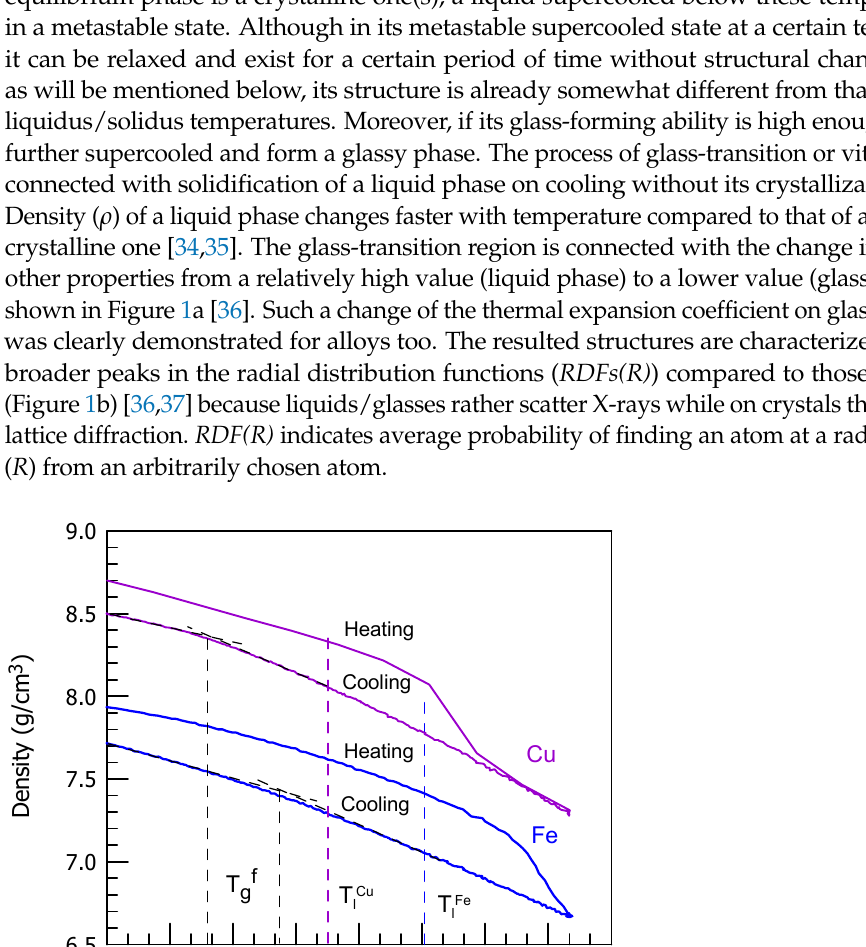
(b) Figure 1. Density changes on heating and cooling of Cu and Fe as a function temperature ( a ). Re- produced from [36] with permission of MDPI. RDFs of Fe in liquid at 1820 K (experiment and MD simulation) and glassy at 300 K (MD simulation only) state ( b ). The experimental RDF curve is taken from [37]. Vitrification of metallic liquids illustrated in Fig. 1a was modeled using molecular dynamics (MD) simulation. High critical cooling rates of about 10 13 K/s are required to vitrify pure metals in MD simulation [38,39] though theoretical calculations [40] and ex- periments with submicron scale samples [4] suggest a lower critical cooling rate (of about 10 9 K/s) for glass-transition in pure metals, especially with BCC lattice. Formation of an alloy by adding second component to a pure metal, for example Zr to Cu, drastically de- creases the critical cooling rate [41] but does not affect the glass-transition region. The transition from liquid to glass can also be detected using temperature variation in the first maximum and minimum of RDF ( R ) or PDF ( R ) [ 42,43] . The reduced radial dis- tribution function or pair distribution function ( PDF ( R ), also called g ( R )) corresponds to the number of atoms at a distance R from an arbitrarily chosen atom divided by an average number of atoms geometrically expected at this distance from the atomic number density. PDF(R) of some FCC and BCC metals obtained using classical molecular dynamics